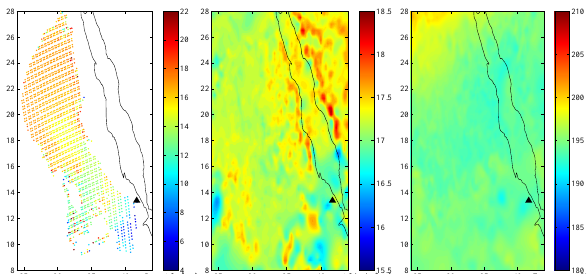
Fig. 3. (Left) IASI retrieved SO 2 altitudes on 13 June (evening over- pass). (Middle) Altitude of the tropopause on 14 June (derived from Eumetsat IASI L2 data). (Right) Temperature at the tropopause on 14 June (derived from Eumetsat IASI L2